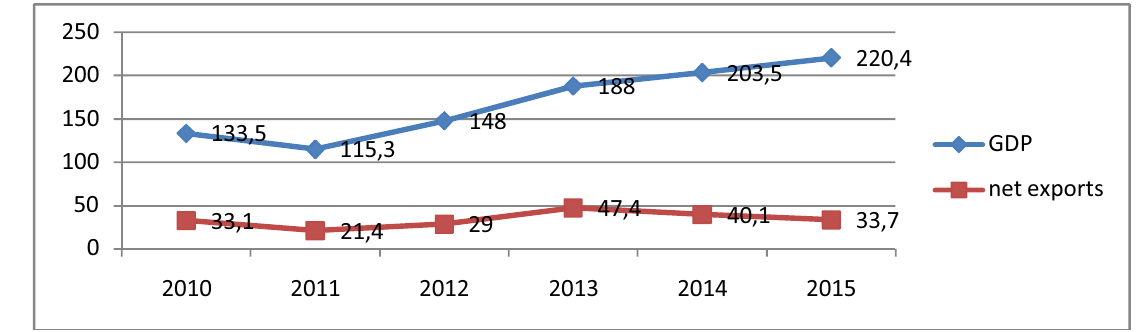
Fig. 3. Dynamics of GDP and net